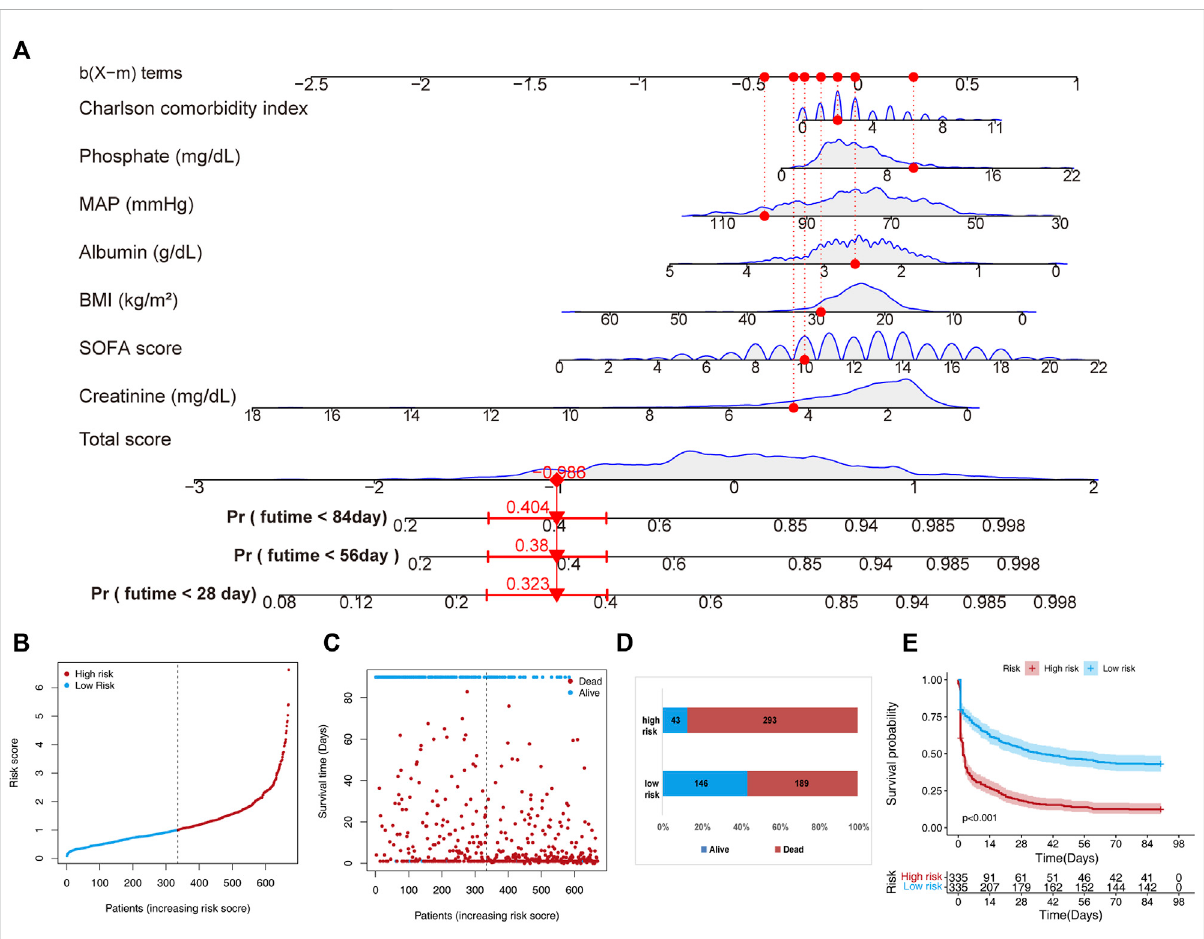
FIGURE 2 A nomogram developed for predicting short-term mortality based on the training set. (A) The nomogram is based on the seven factors determined using Cox ’ s assessment of risks. (B) The distribution of risk scores is derived from the nomogram scoring approach. (C) Distribution of participants in the low and high score categories based on their survival status. (D) Comparison of survival risk between the two groups. (E) Overall survival curves separated by groups with low and high